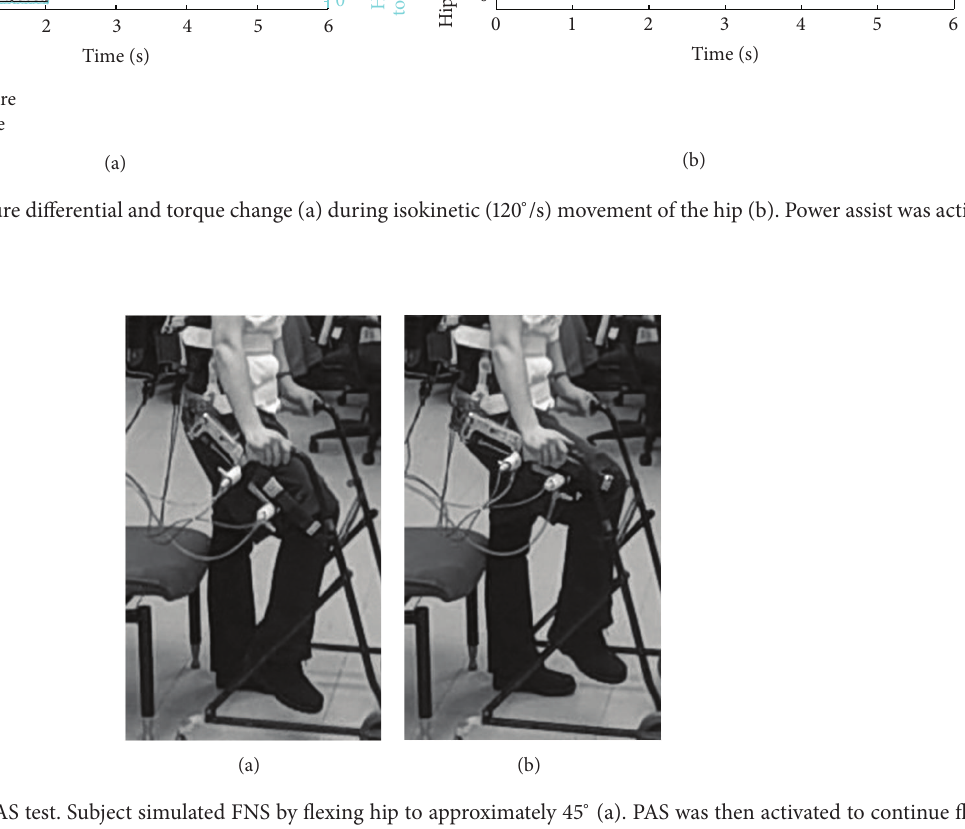
Figure 6: Able-bodied PAS test. Subject simulated FNS by flexing hip to approximately 45 ∘ (a). PAS was then activated to continue flexing the hip to approximately 77 ∘ with minimal user assistance or resistance